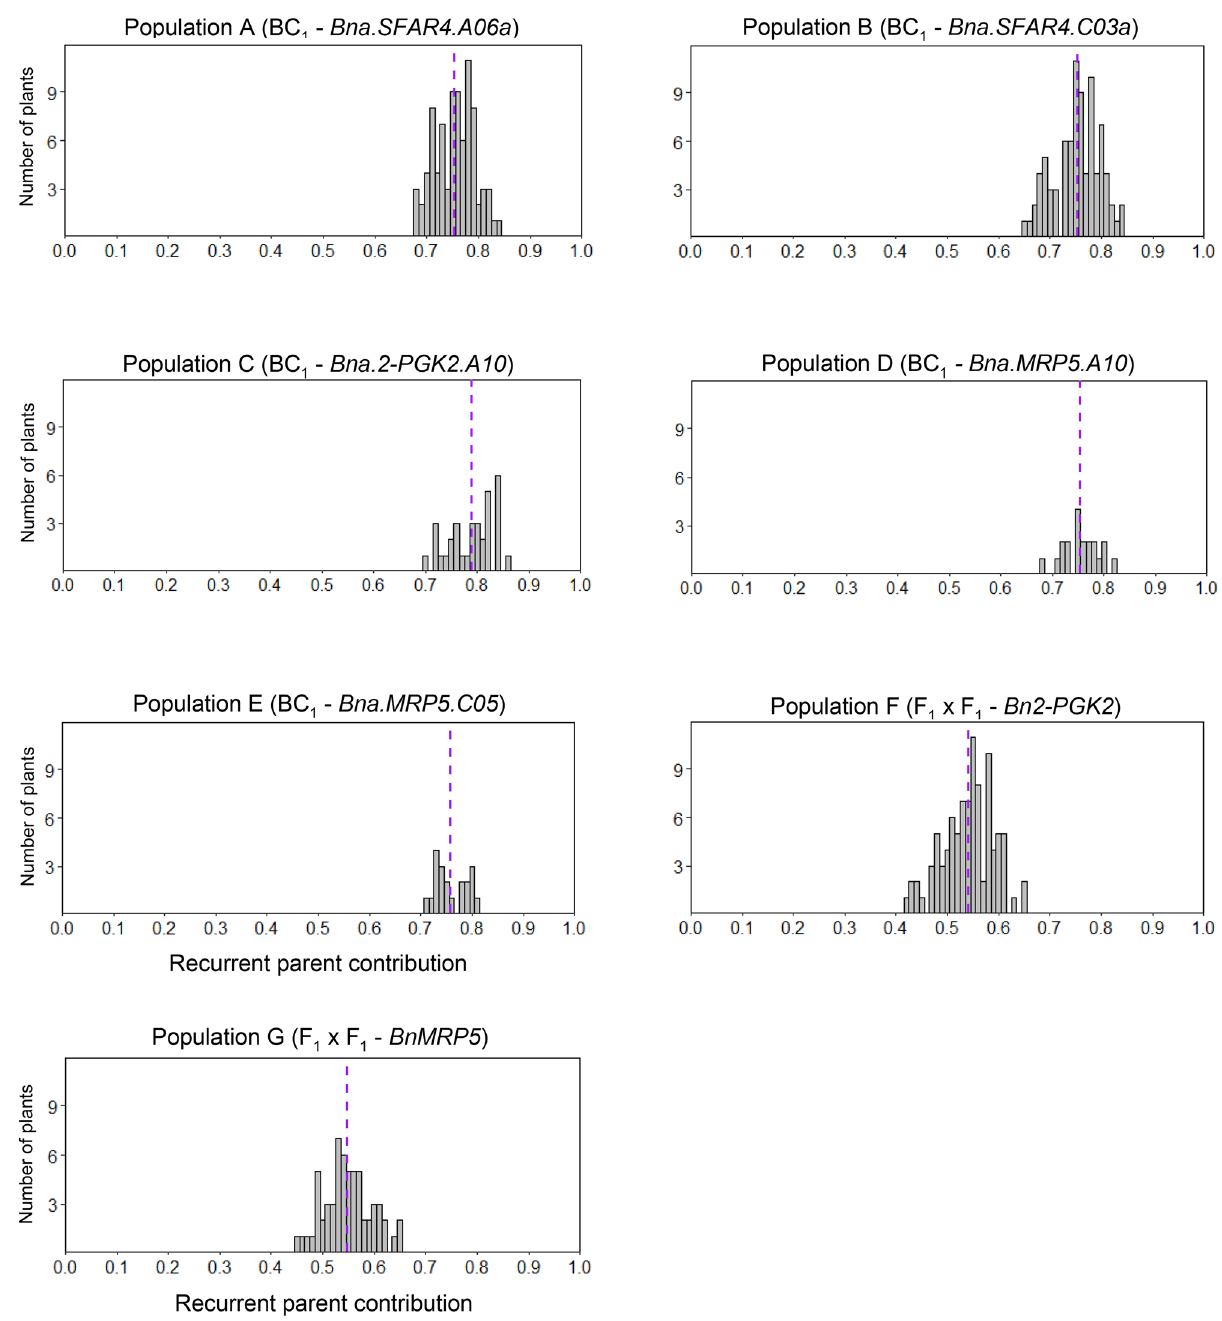
Figure 2. Proportion of the recurrent parent in five BC 1 single mutant and two F 1 × F 1 double mutant populations. The purple lines indicate the average of the recurrent parent’s genome